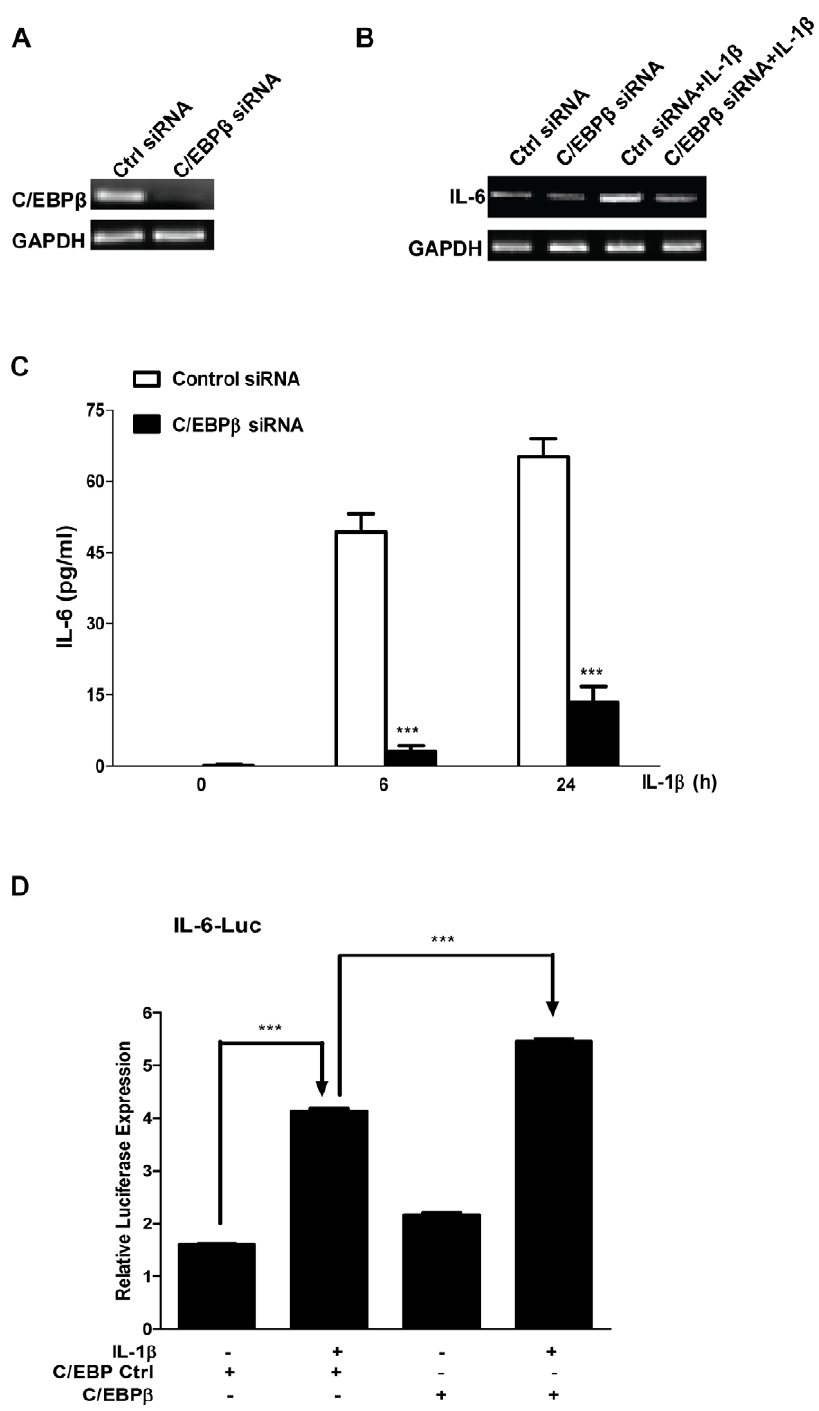
Figure 6. Knockdown of C/EBP b by siRNA inhibits IL-1 b -induced IL-6 production in MLE12 Cells. A, MLE12 cells were transfected with 40 nM control siRNA or C/EBP b -specific siRNA. 24 h later, RNAs were isolated and RT-PCR was performed by using primers for C/EBP b and GAPDH, respectively. B and C, MLE12 cells were transfected with 40 nM control siRNA or C/EBP b si RNA. 24 h later, the cells were incubated with or without 20 ng/ml IL-1 b for different time periods. B, RNAs were isolated and RT-PCR was performed by using primers for IL-6 and GAPDH, respectively. C, Supernatants were harvested for ELISA. The data were expressed as means 6 S. E. M., N=8. D, MLE12 cells were transfected with indicated plasmids. 24 h later, the cells were treated with 20 ng/ml IL-1 b for 6 h. Cell lysates were subjected for luciferase activity measurement. Luminometer values were normalized for expression from a co-transfected thymidine kinase reporter gene. The data were expressed as means of three experiments 6 S. E. M.